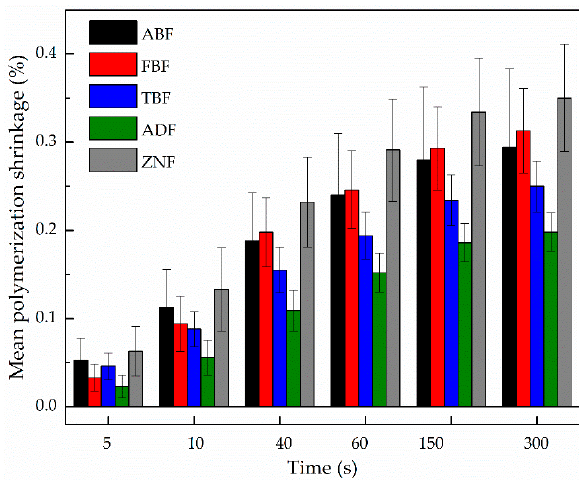
Figure 4. Comparison of the mean linear polymerization shrinkage (%) in different instants, for the RBCs studied. RBCs